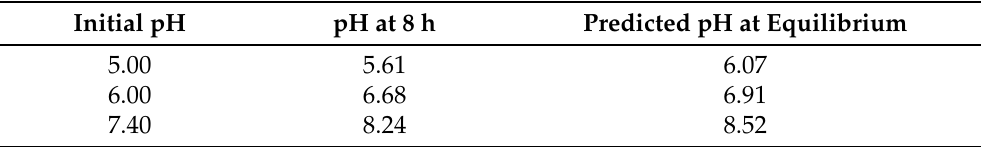
Table 1. pH drift measured with the pH meter after 8 h and predicted pH at equilibrium using the ICE table method. Depending on the initial pH, it takes 9 to 14 h to reach the